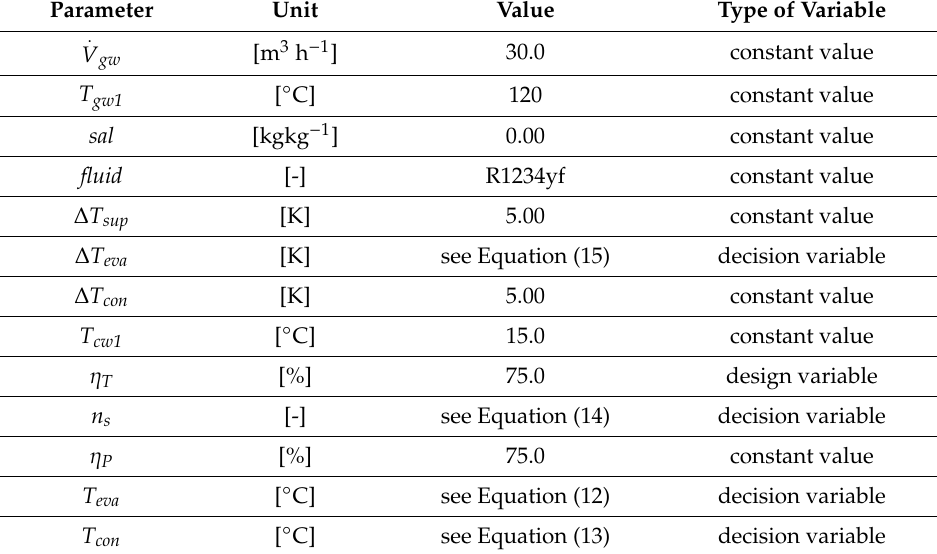
Table 1. Operating parameters of the ORC